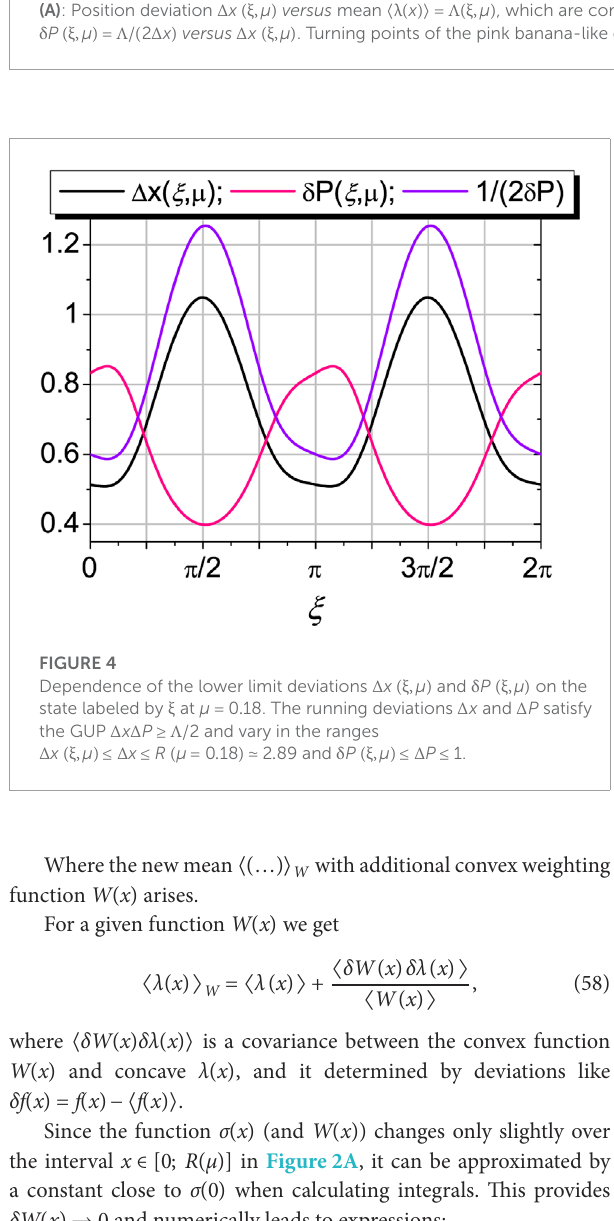
with additional convex weighting W